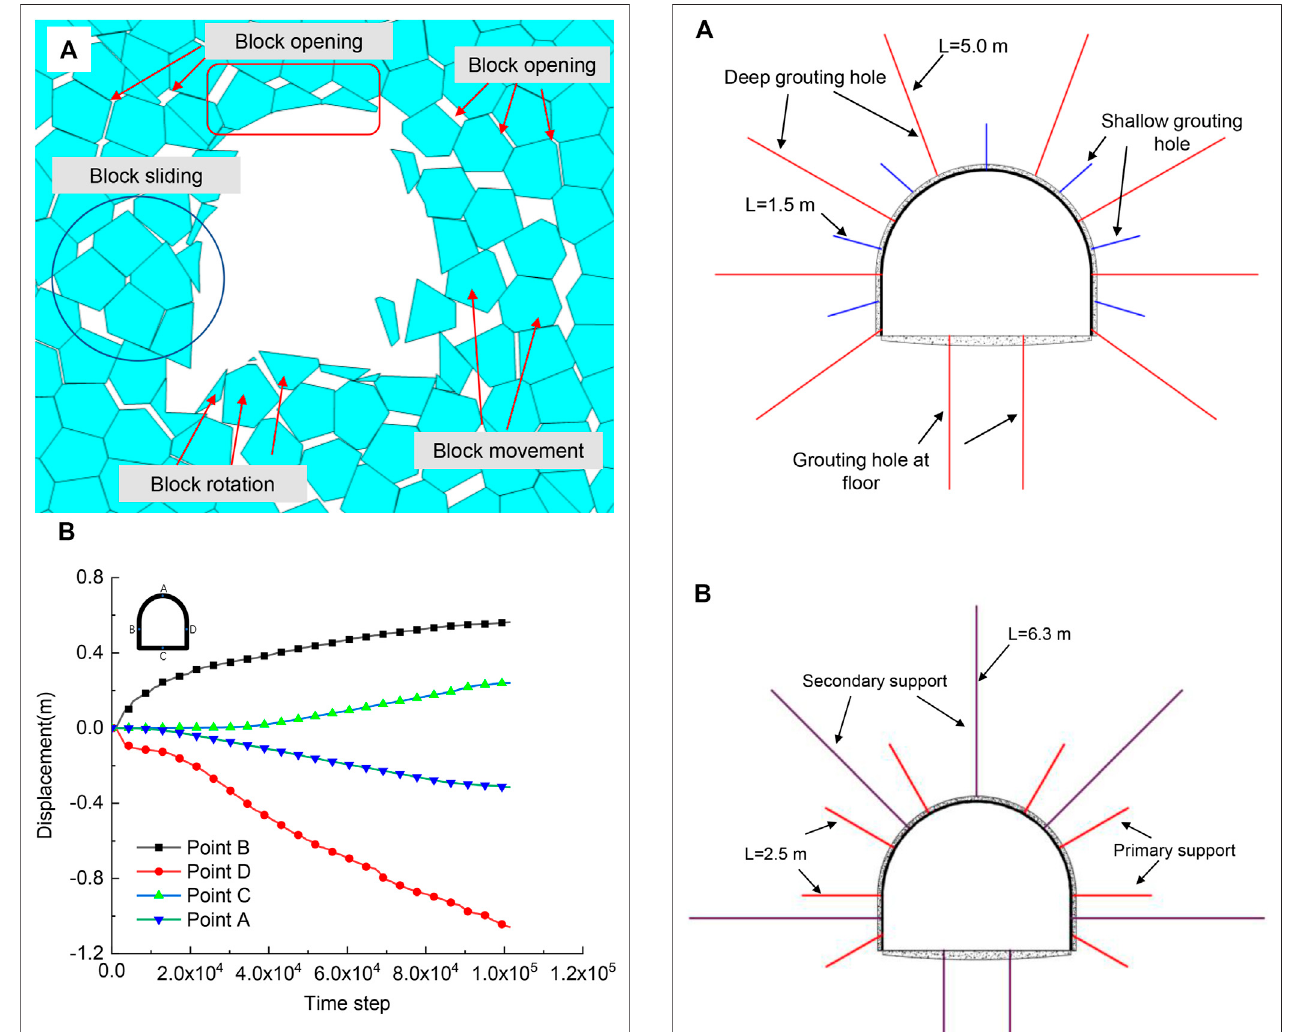
FIGURE 9 | The fi nal simulation results. (A) The fi nal failure mode of research roadway. (B) The displacement of monitoring points without support.